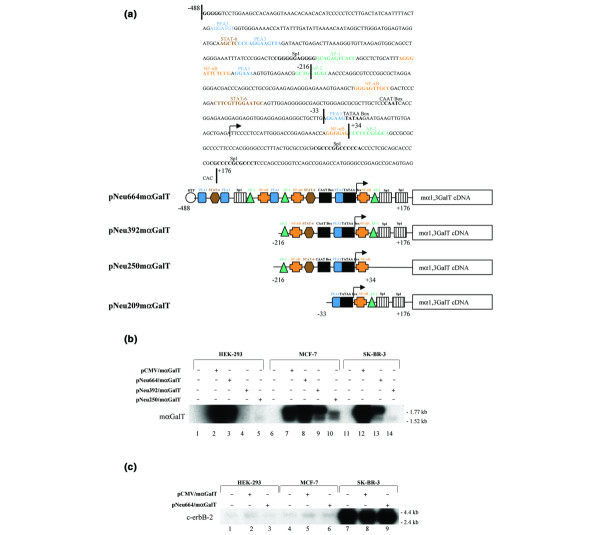
Promoting activity of newly designed forms of pNeu in various cell lines differentially expressing c-erbB-2 (a) Schematic representation of various forms of pNeu constructed upstream of the murine α1,3galactosyltransferase (mαGalT) cDNA. The transcription start site is indicated by arrows, and the 5' end points of the various forms of pNeu by bold bars. (b) Northern blot analysis of expression of mαGalT driven by the CMV promoter (pCMV) and the various forms of constructed pNeu. (c) Northern blot analysis of c-erbB-2 expression in stably transfected HEK-293, MCF-7 and SK-BR-3 cells. Total RNAs were electrophoresed and probed with [α-32P]-random-labeled mαGalT or c-erbB-2 cDNA, and thereafter with glyceraldehyde 3-phosphate-dehydrogenase (GAPDH) cDNA as a control.